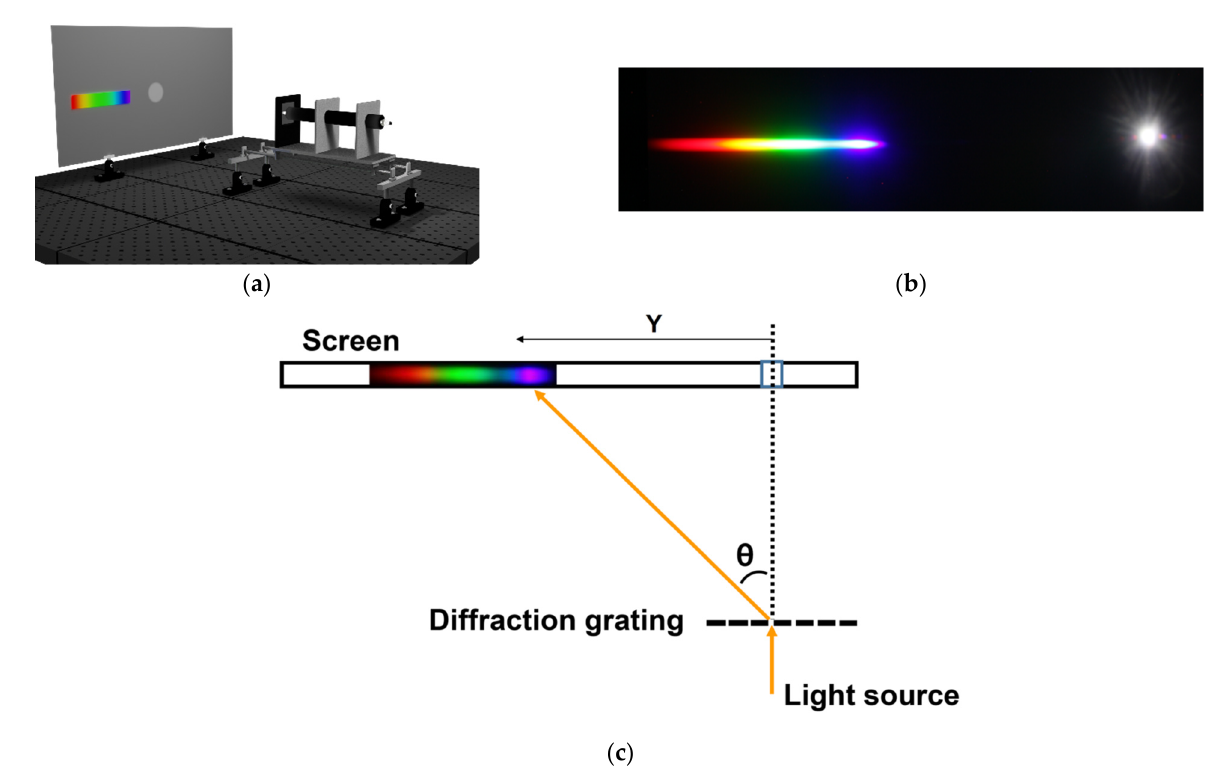
Figure 3. ( a ) Schematics of the experimental test bench set-up for the H-W curve measurement. LED light source, single slit (diameter 0.5 mm), collimator, diffraction grating (830 lines/mm), and screen were used. ( b ) One example picture showing the photographed diffraction patterns appearing on the screen. ( c ) Sketch of a distance (Y) measurement from the right central white image to the left each color band. From this value, we obtain the angle (θ) between the normal line of ray and the diffraction maxima.